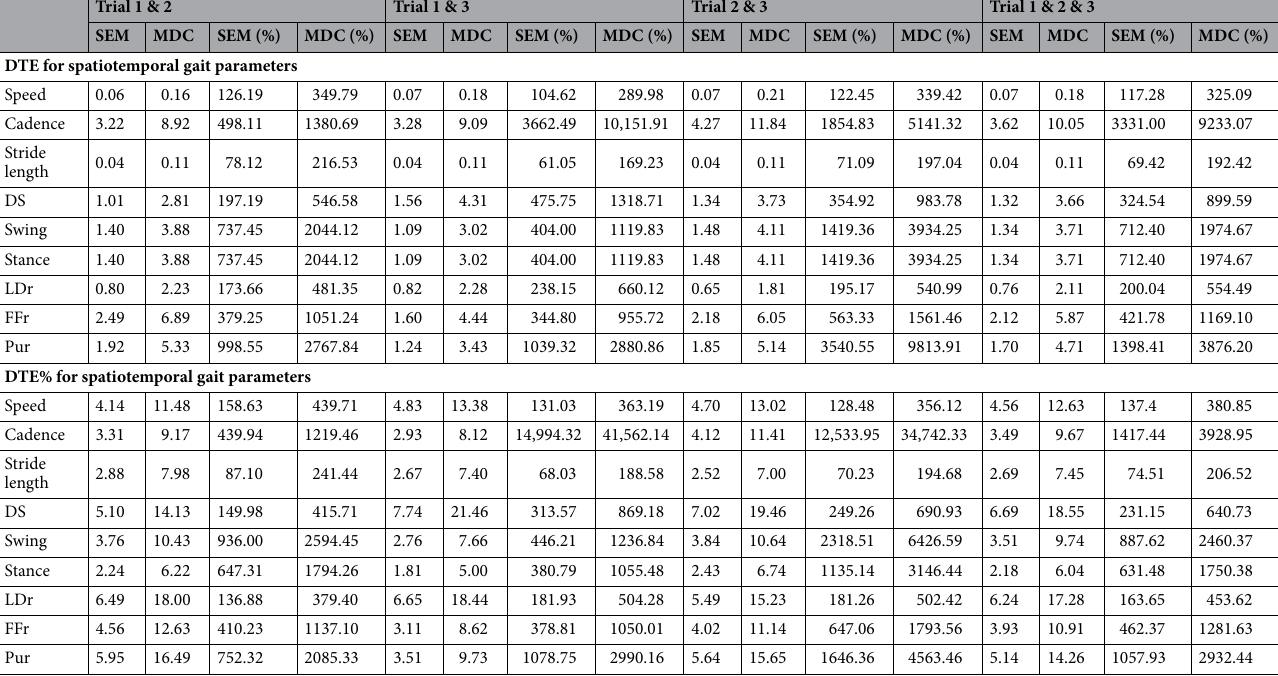
Table 7. Standard error of measurement (SEM) and minimal detectable change (MDC) for DTE and DTE percentage for trial 1–2-3. Abbreviations: DTE = dual task effects, SEM = standard error of